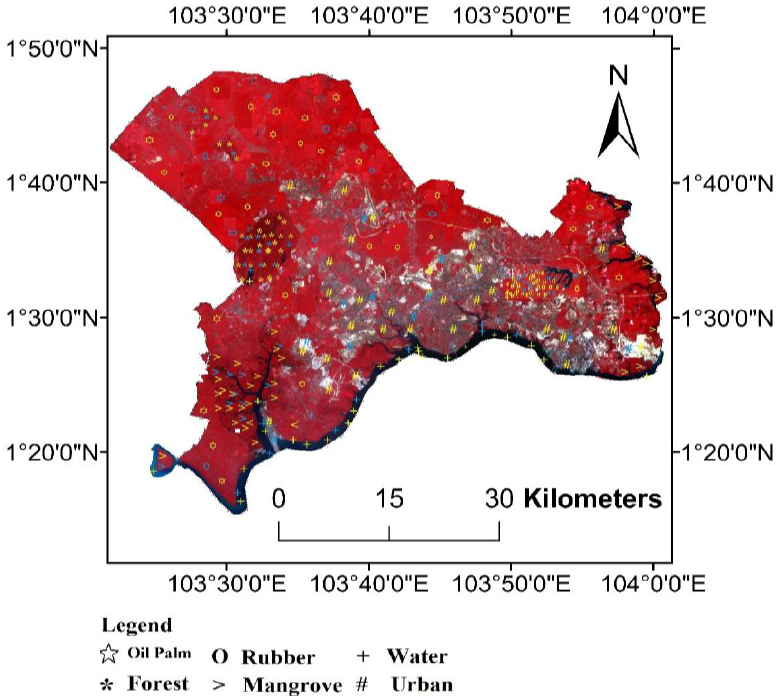
Figure 3. The distribution of test samples (30 polygons) and validation samples (10 polygons) for each land cover types in the study area. Yellow color symbols show the test samples and blue color represents the validation samples